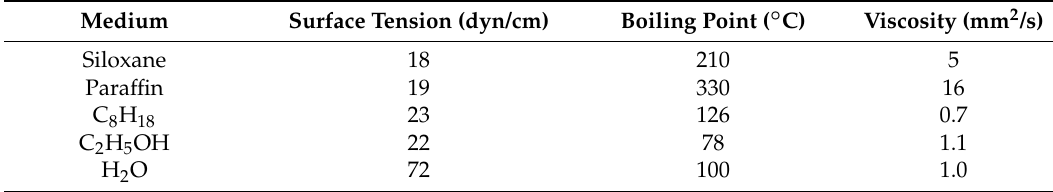
Table 1. The parameters of different dyeing media.